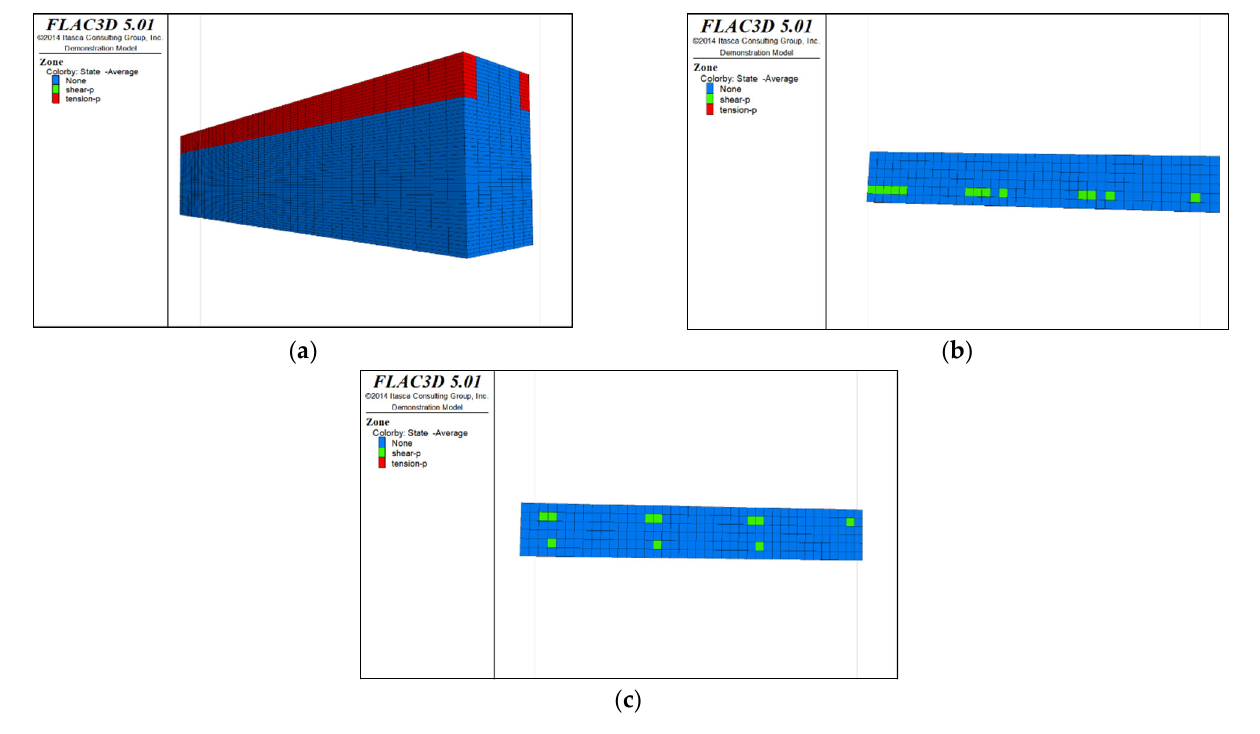
Figure 7. Distribution of plastic zones in the roof protection layer under Scheme D. Note that the heigt of each slice is 0.5m. ( a ) 3D drawing. ( b ) plan of roof protection layer (the first slice). ( c ) plan of roof protection layer (the second slice).